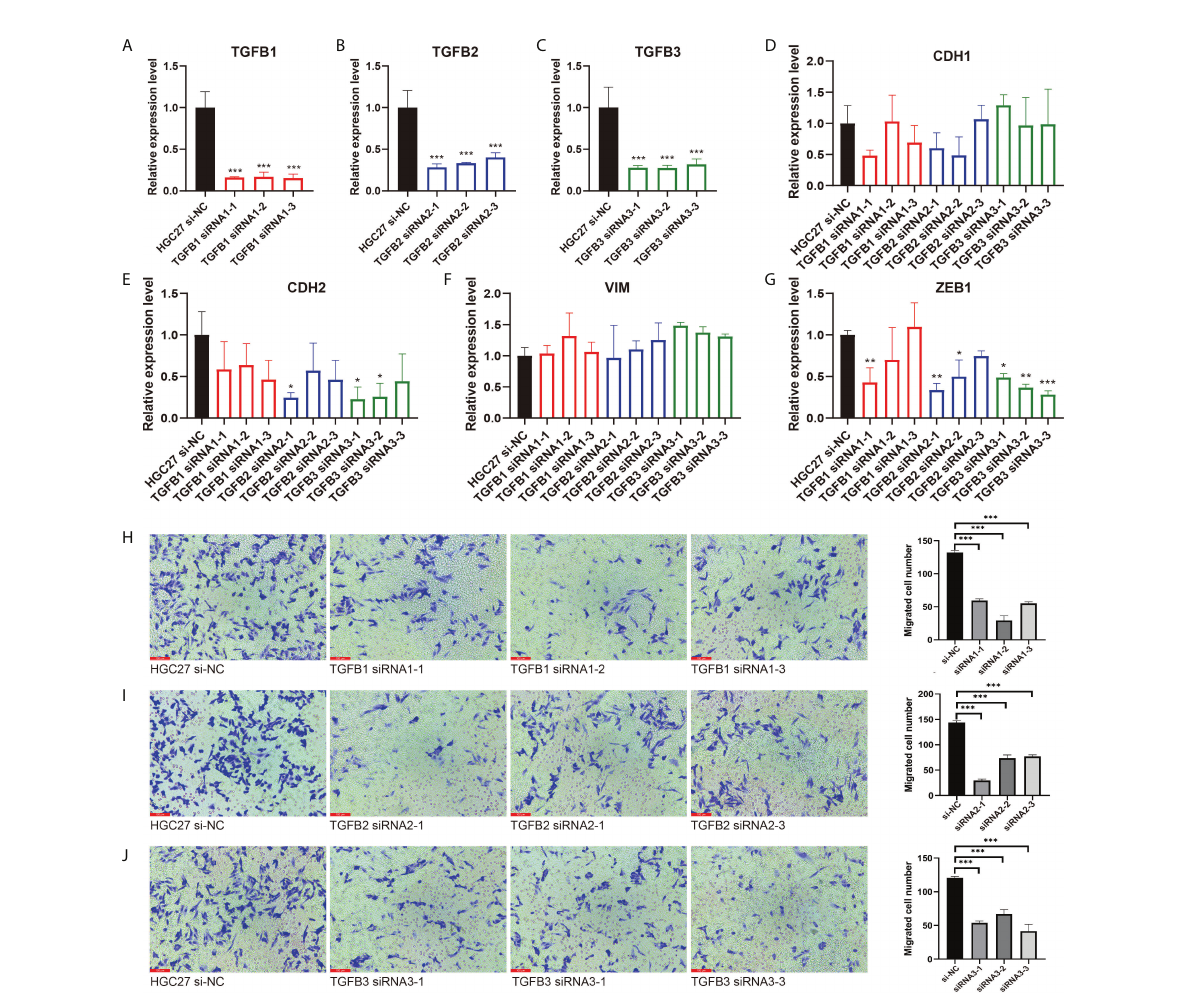
FIGURE 8 Inhibition of EMT and migration progression after silencing of TGF b . (A – C) The TGF b 1, TGF b 2 and TGF b 3 silencing group was compared with the HGC27 normal group, respectively. (D – G) qRT – PCR experiments showed the changes of EMT – related markers CDH1, CDH2, VIM and ZEB1 after TGF b silencing. (H – J) Detection of migration ability of gastric cancer cells in TGF b – silenced group and control group. * P < 0.05; ** P < 0.01; *** P <